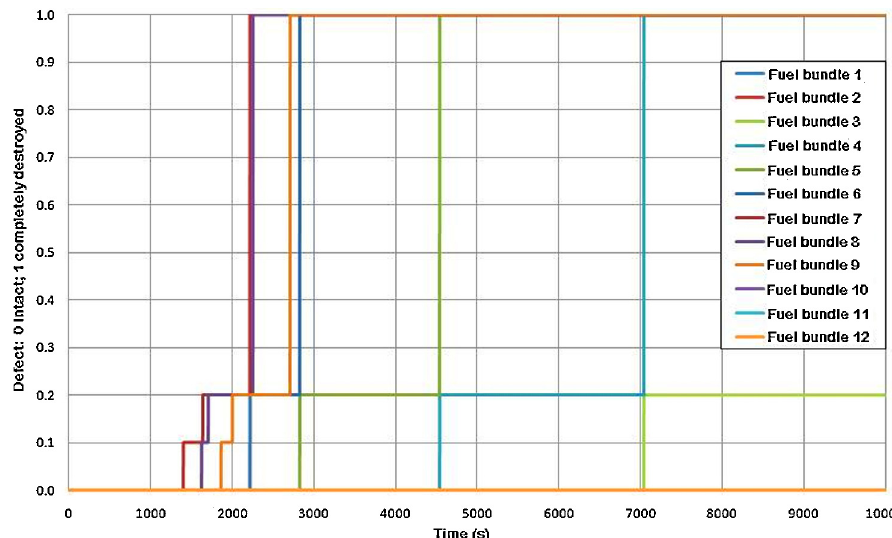
Fig. 6. Fuel degradation for the outside fuel pin ring in the CANDU bundle [5].